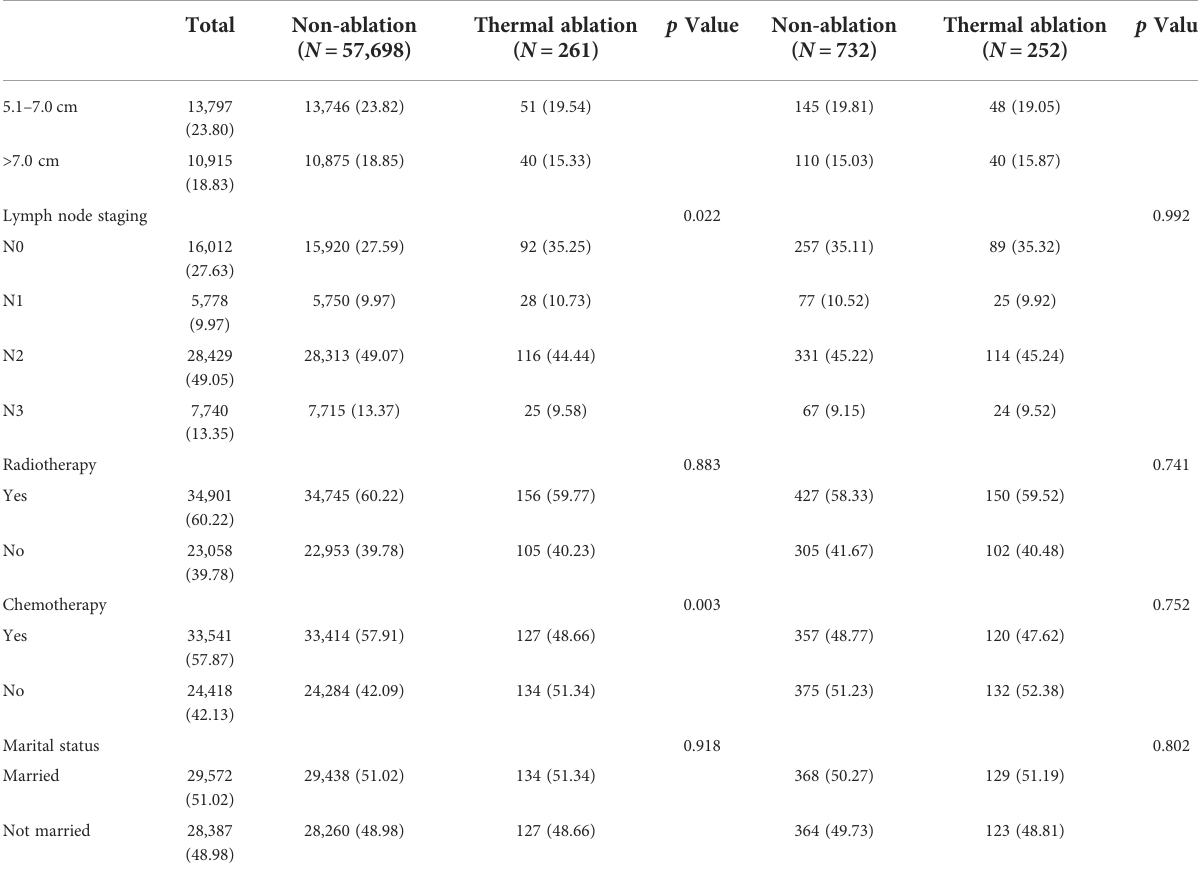
NSCLC, non-small cell lung cancer; PSM, propensity score